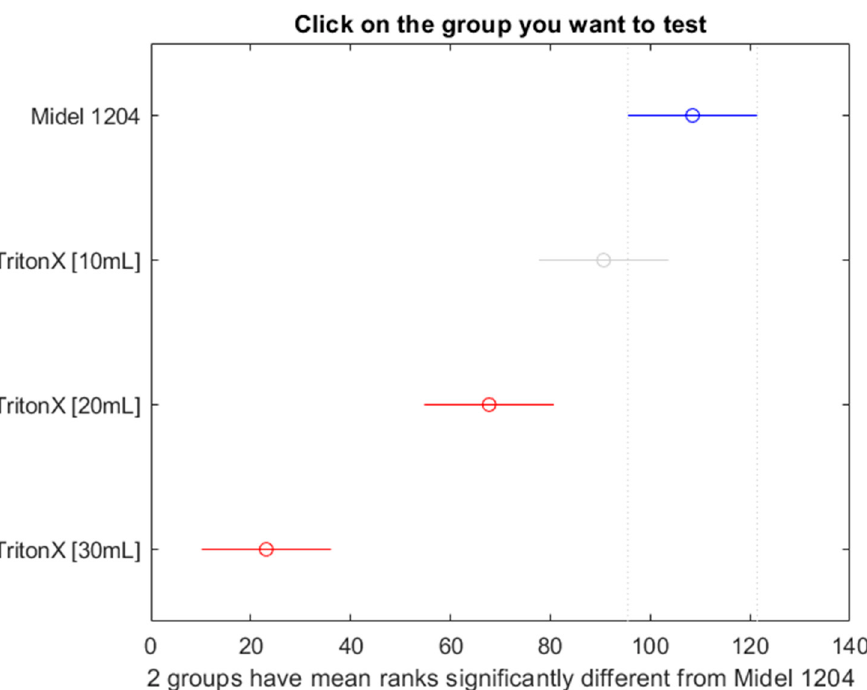
Figure 18. Post hoc Bonferroni test for oil Midel 1204 with different concentrations of surfactant Triton X.